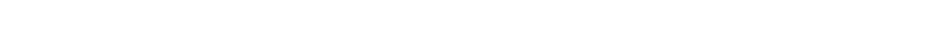
FIGURE 3 |Training effects on (A) solution rate and (B) response latencies. Error bars depict 1 SE of the